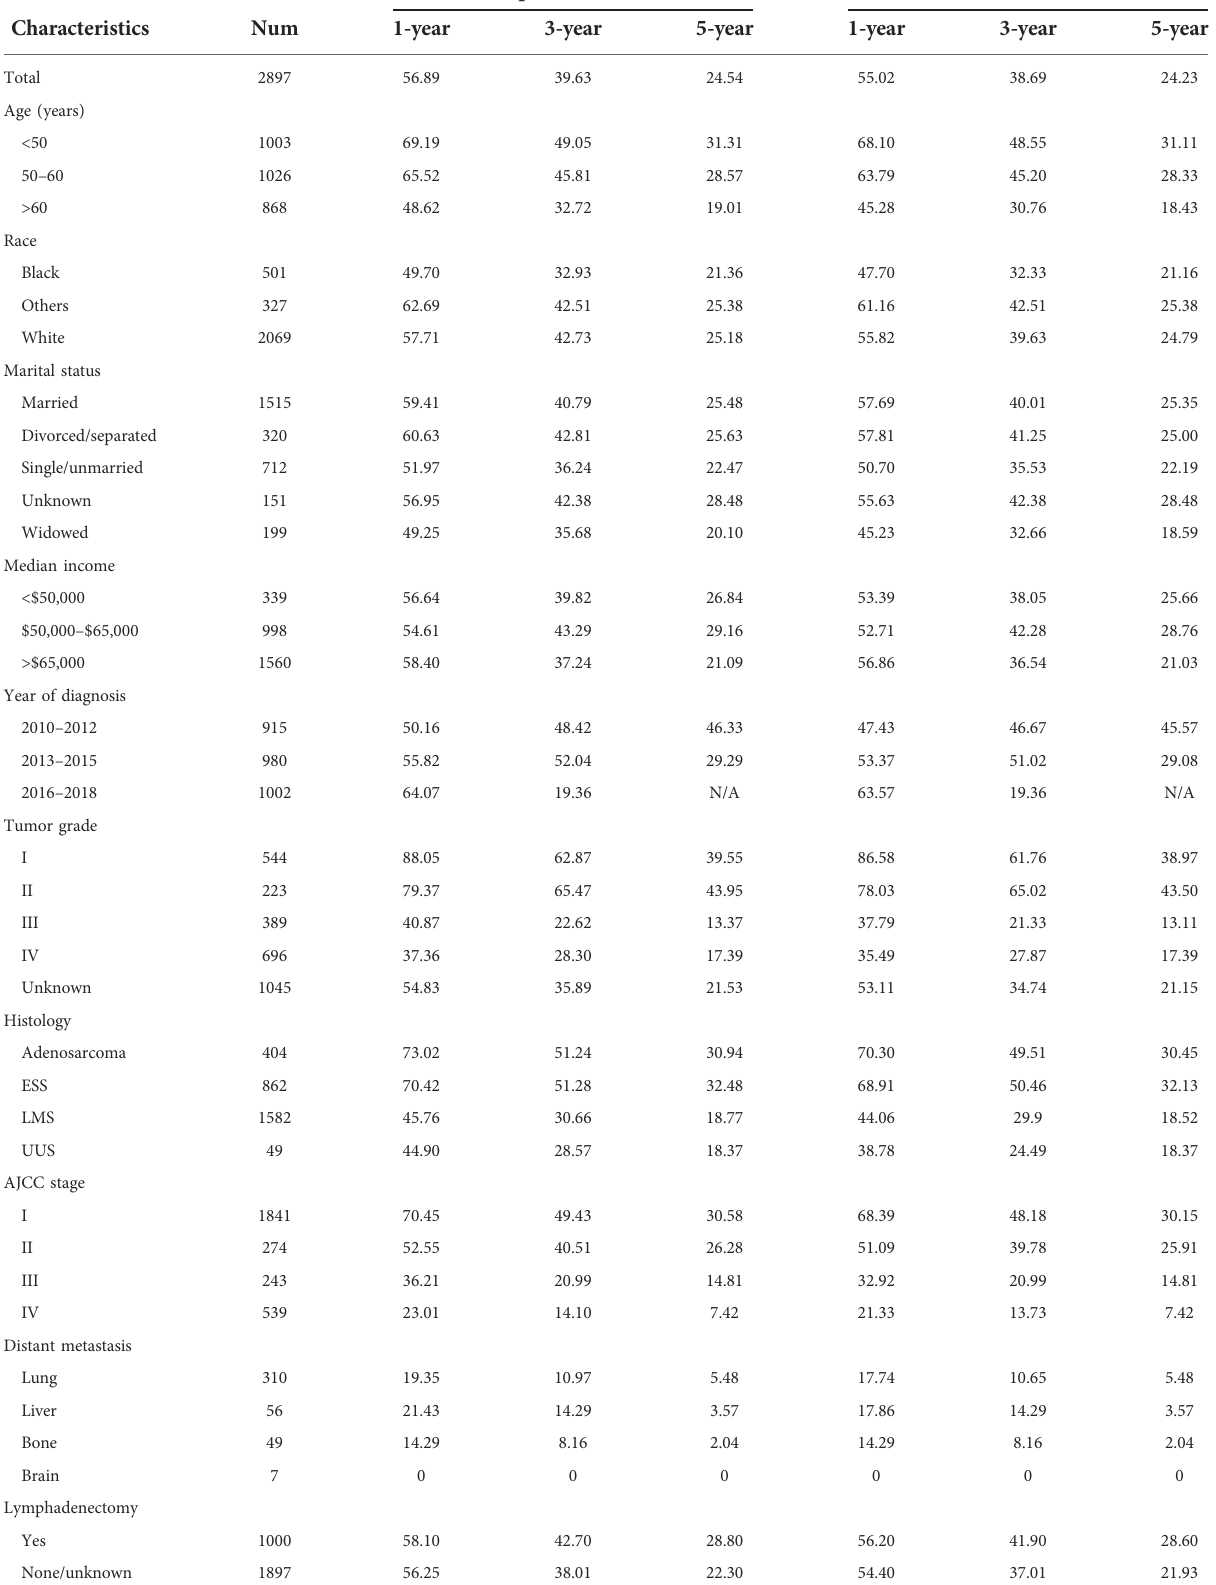
TABLE 1 The 1-, 3- and 5-year cause-speci fi c survival and overall survival in terms of uterine sarcoma patients.